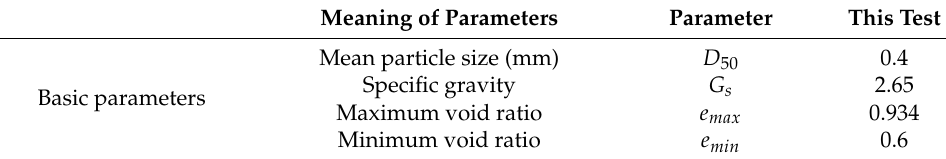
Table 2. Typical engineering properties of Toyoura sand in Wang’s test.